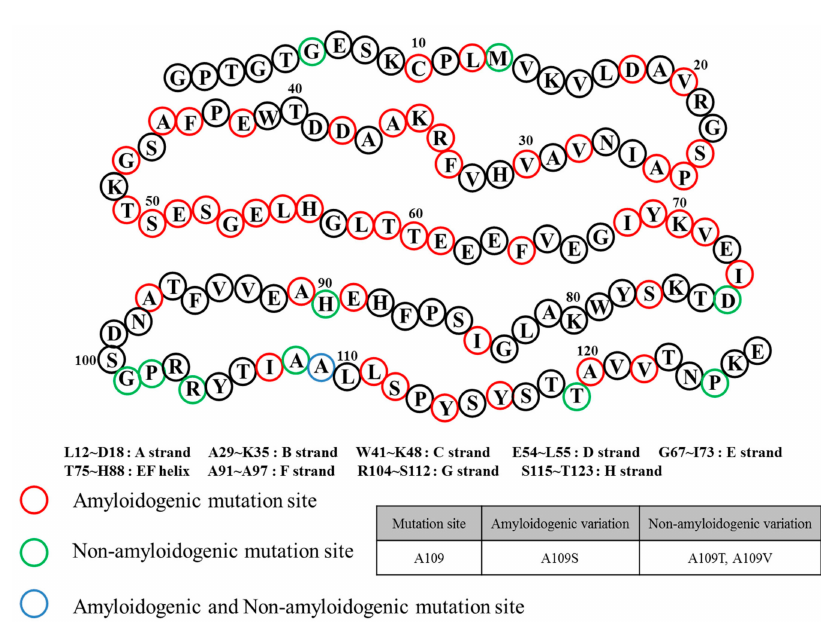
Figure 4. Transthyretin mutation sites and relation to